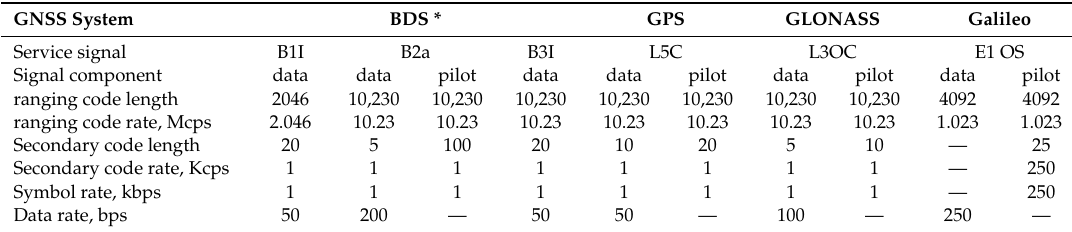
Table 1. Structures of the typical Global Navigation Satellite System (GNSS) signals modulated with secondary code. GNSS System BDS * GPS GLONASS